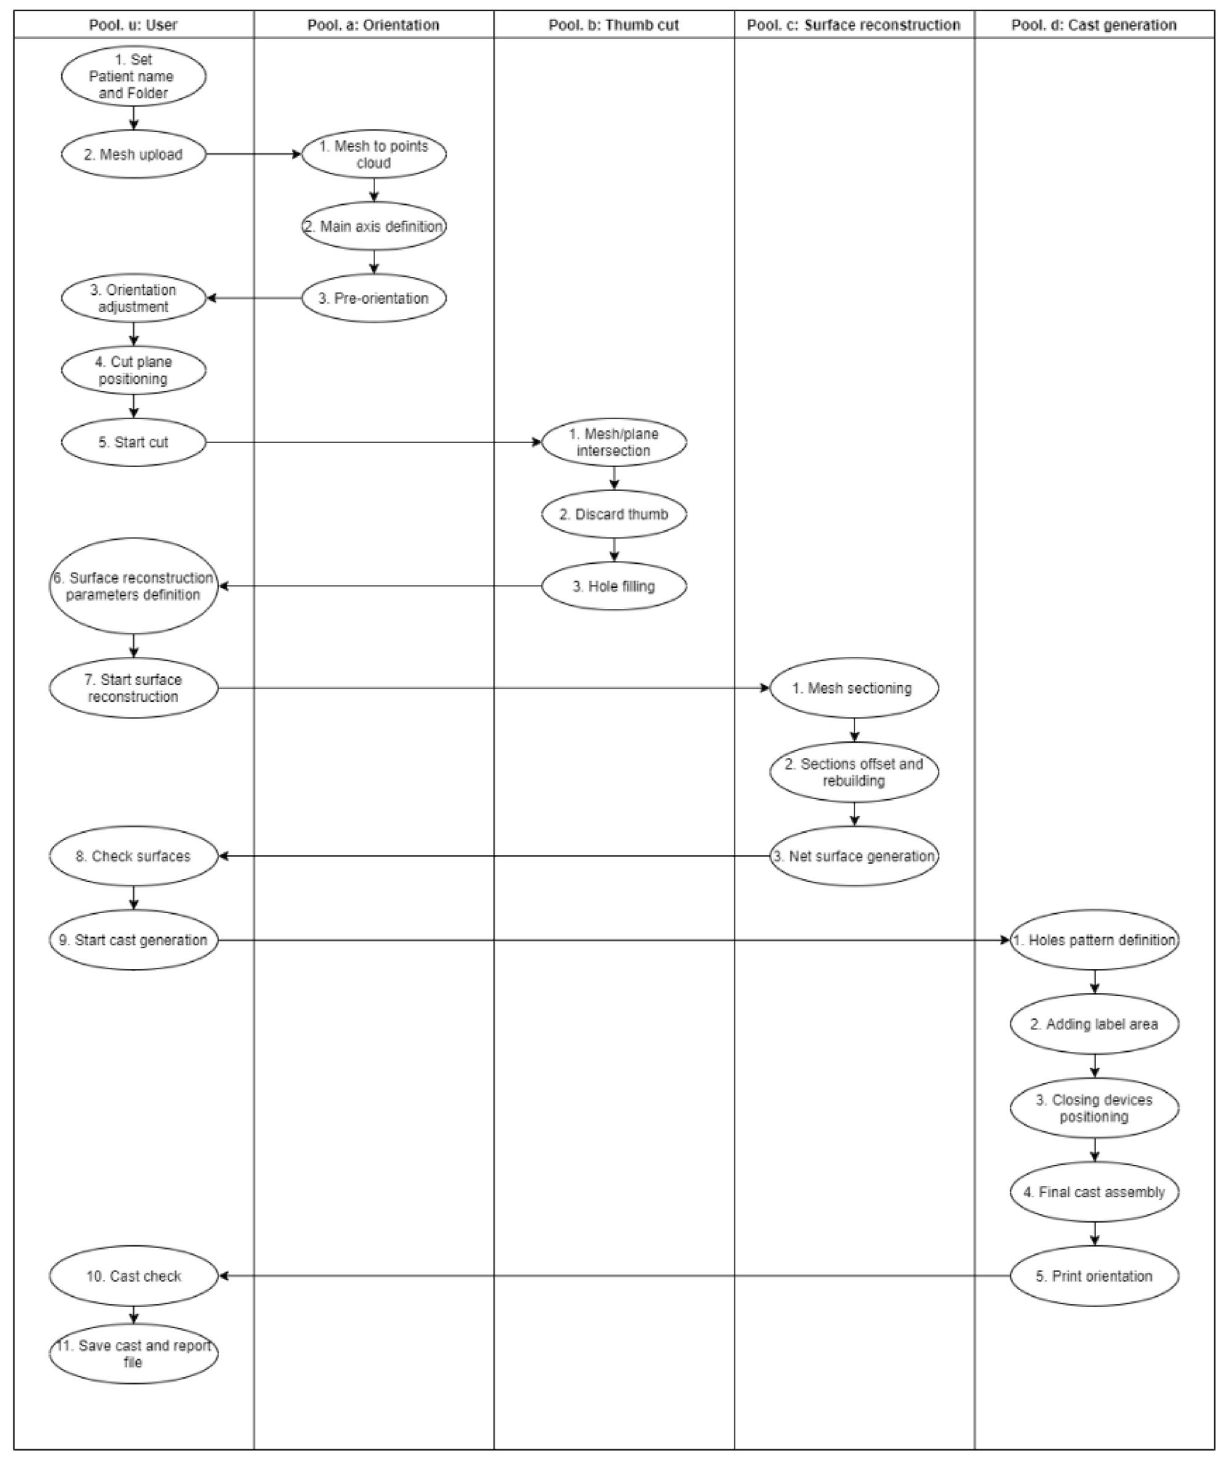
Fig. 4 Full Grasshopper® processing UML: description of activities sequence in